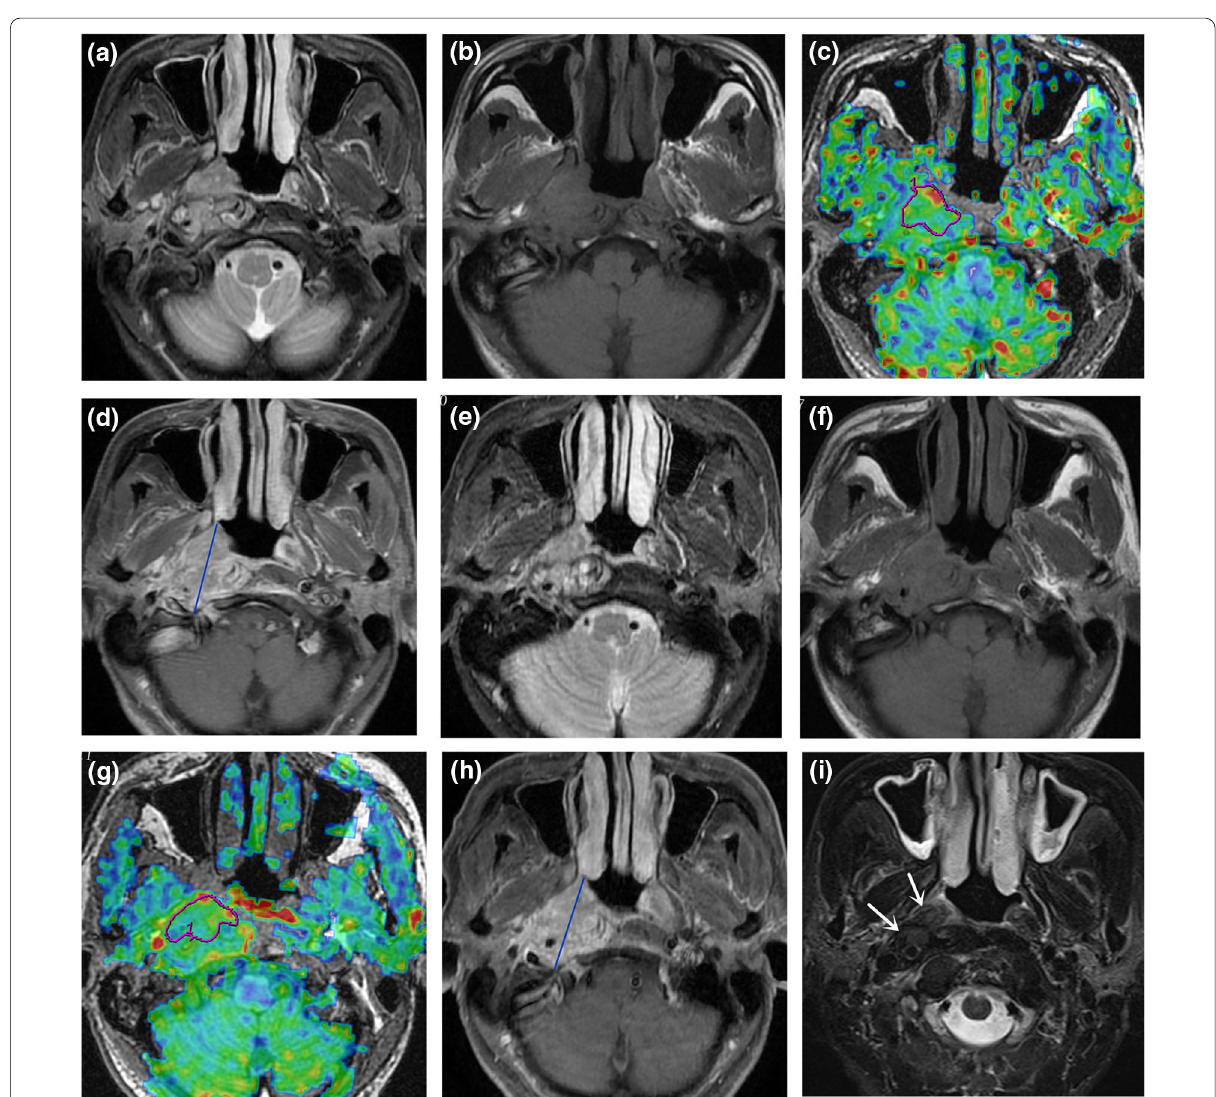
Fig. 3 A male patient aged 57 years with stage III nasopharyngeal carcinoma (T3N2MO). Pathological examinations suggested non-keratinizing undifferentiated squamous cell carcinoma. Before treatment, T2-IDEAL and T1WI images revealed nasopharyngeal masses on the right around the right levator veli palatini, tensor veli palatini, and internal carotid artery ( a and b ); the ASL series integrated with BRAVO series revealed high mass perfusion ( c ) with a TBF value of 110.34 mL 100 g − 1 min − 1 ; the maximum primary tumor diameter measured on axial T1WI enhanced imaging was · · 37.84 mm ( d ). Re-examination after the prescribed dose reached 40 Gy suggested minor tumor shrinkage ( e and f ) and slightly high mass